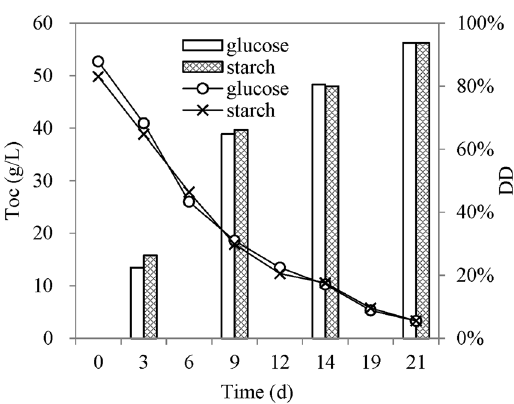
Figure 5. Variation of TOC in the anolyte (0.30 mol/L PMo 12 ) when the continuously-operated LCFC consumed glucose or